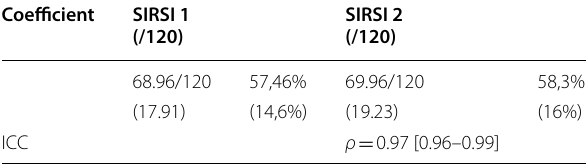
Table 4 : Reproducibility of SIRSI score by Test‑Retest Coefficient